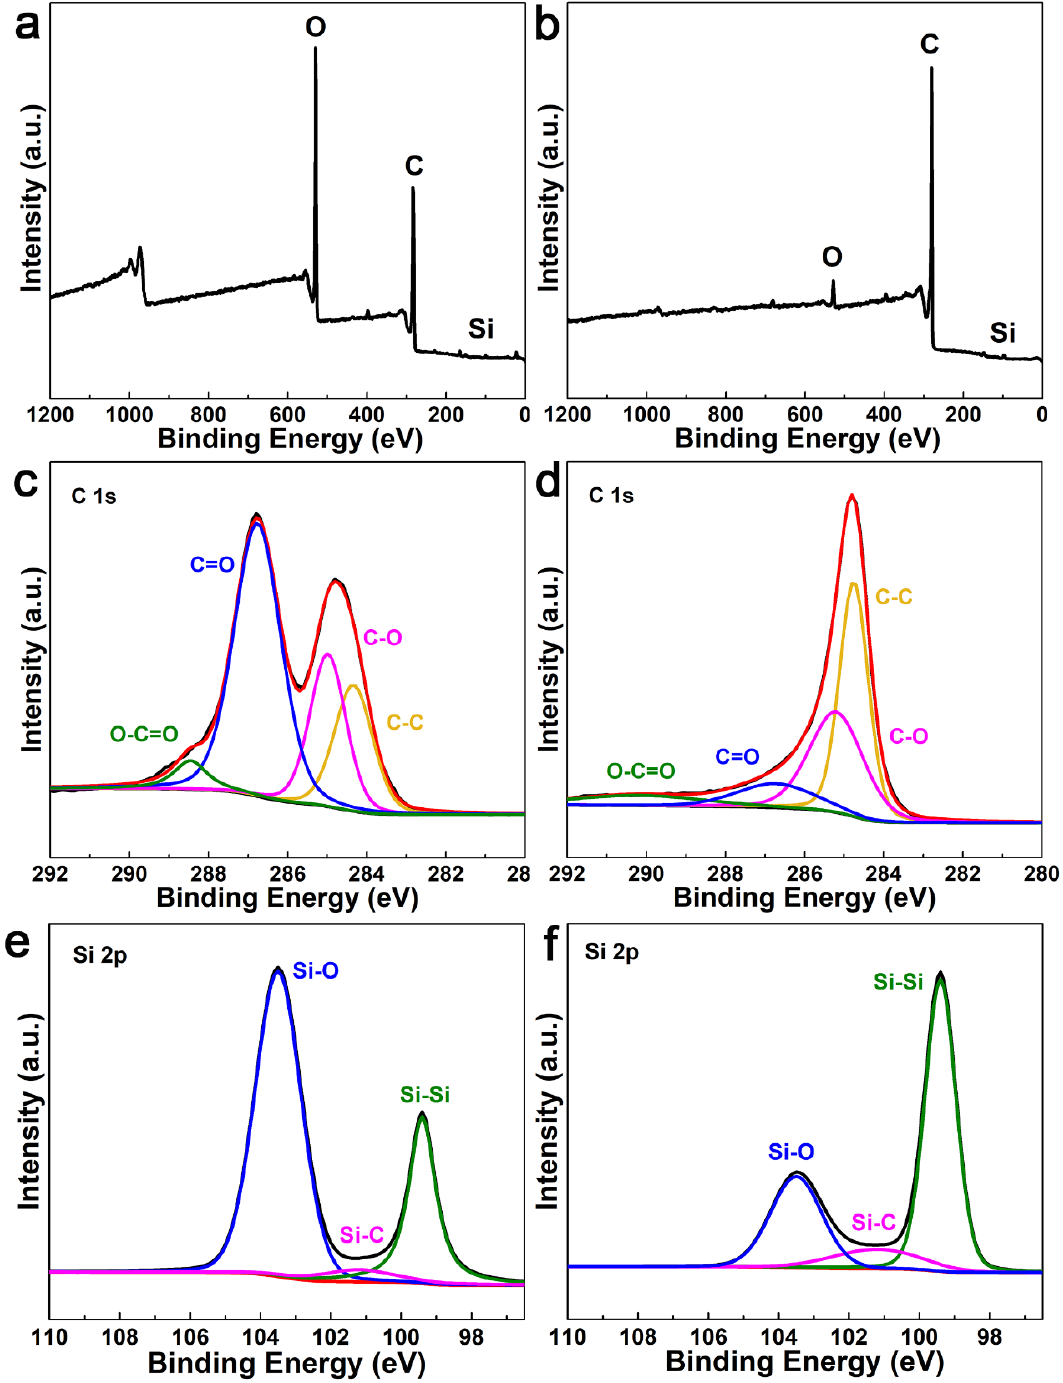
Figure 4. XPS spectra of ( a ) Si/SiO 2 /GO film and ( b ) free-standing Si/void/rGO electrode; C1s curve of ( c ) Si/SiO 2 /GO film and ( d ) free-standing Si/void/rGO electrode; Si 2p curve of ( e ) Si/SiO 2 /GO film and ( f ) free-standing Si/void/rGO electrode.